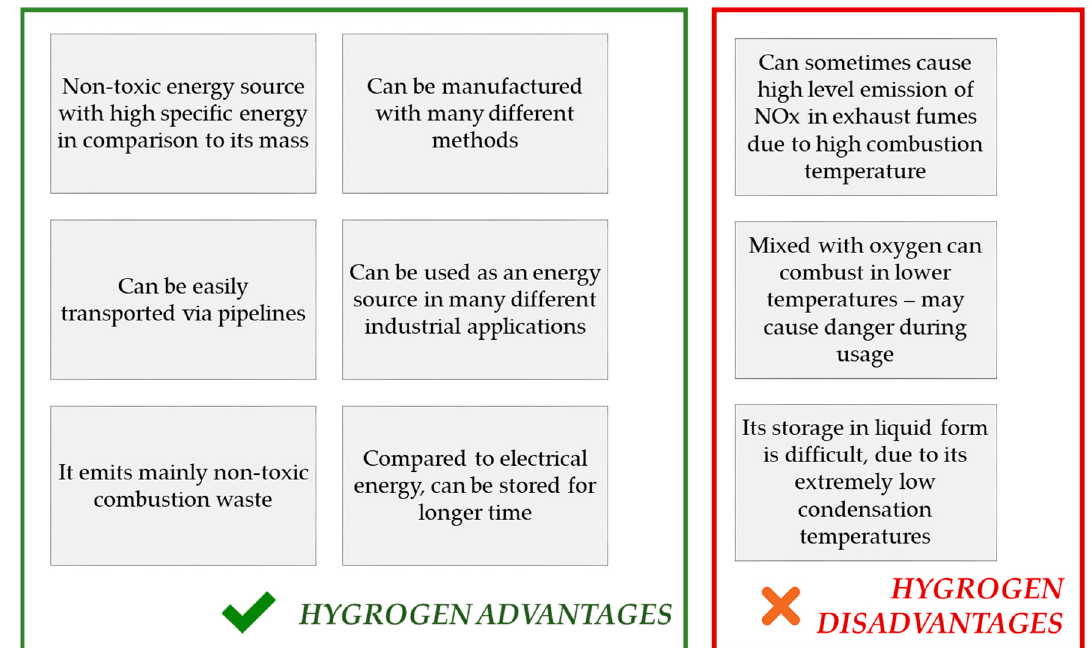
Figure 2. Advantages and disadvantages of H 2 as an energy source.